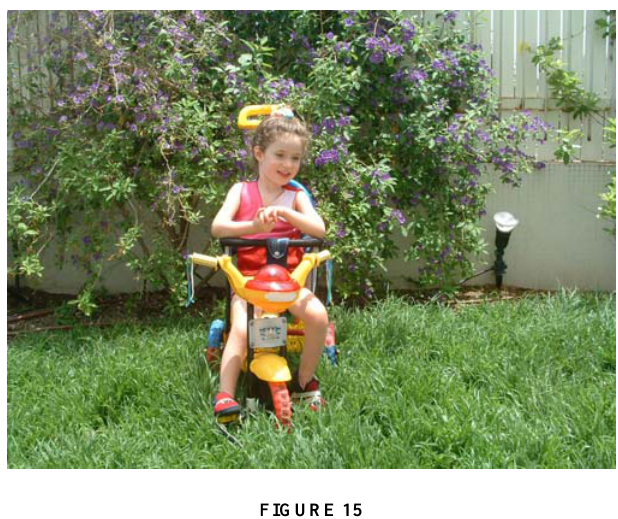
FIGURES 14 and 15. Using a bike both as a recreational and physical activity.